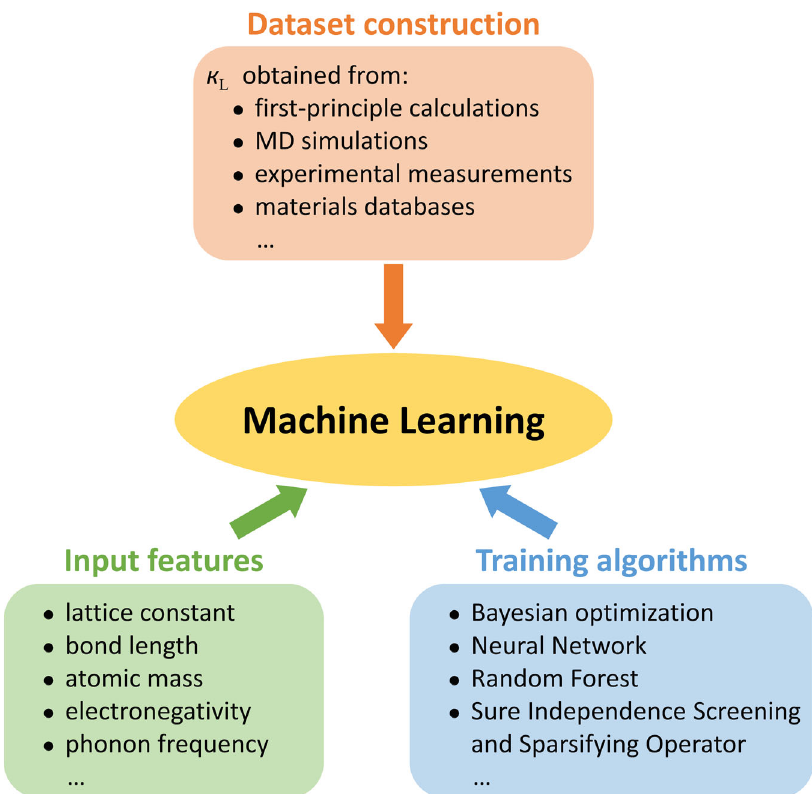
Fig. 1 A schematic illustration of machine learning for the high-throughput prediction of lattice thermal conductivities. Three components are usually involved in machine learning: dataset construction, input features, and training